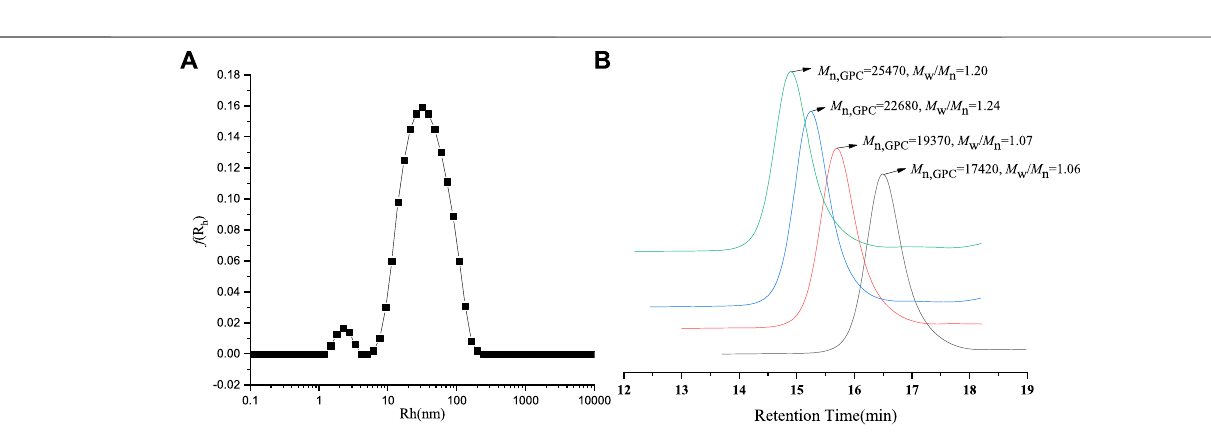
FIGURE 2 | (A) DLS spectrogram for Fe 3 O 4 @ PNIPAM-b-PAzoMA nanoparticles. (B) GPC traces of PNIPAM-b-PAzoMA.